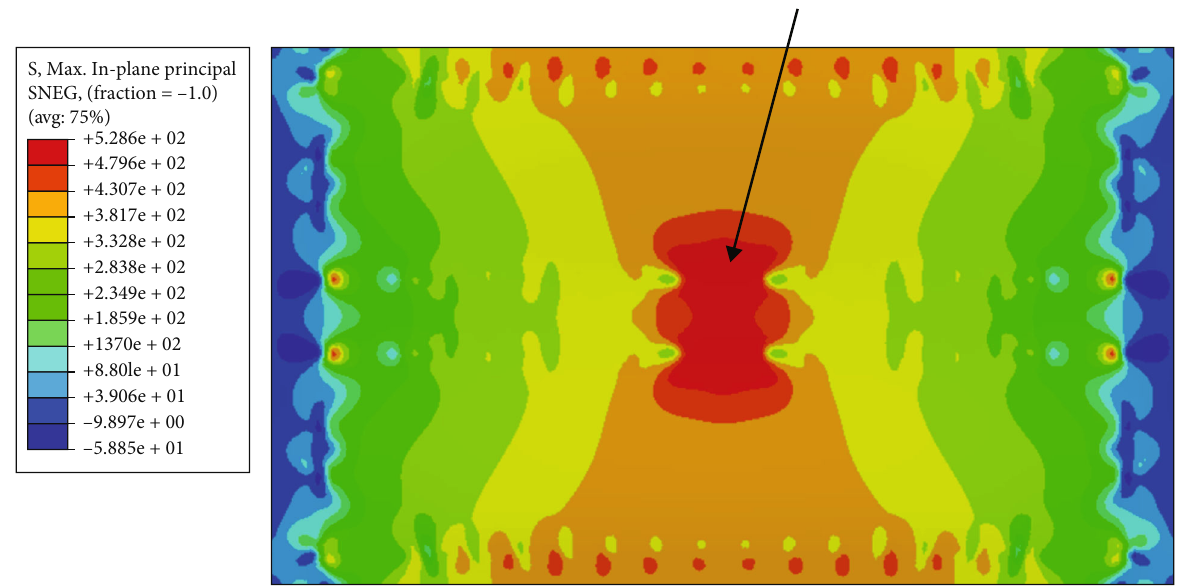
Figure 19: Standard analysis maximum in-plain principal stress in the lower repair panel